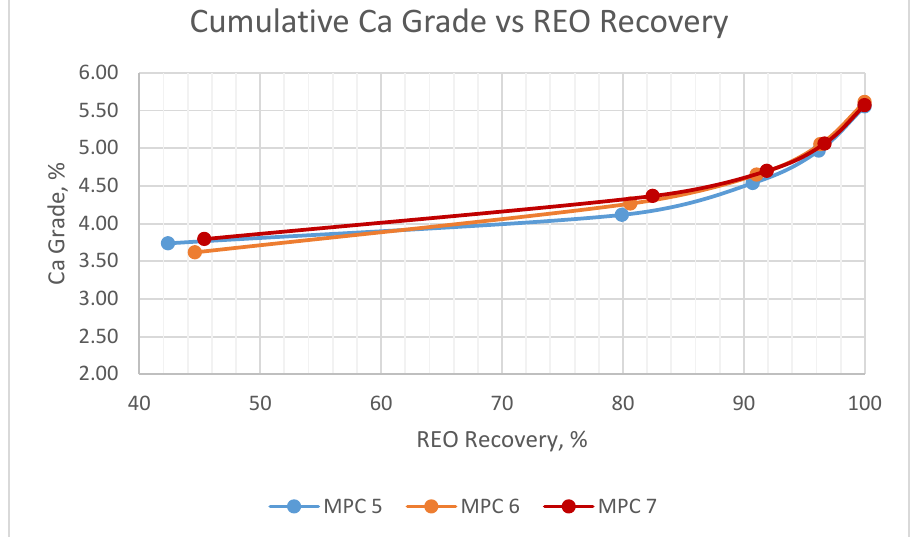
Figure 9. Cumulative gravity concentrate Ca grade vs REO recovery for MPC UF Falcon recovery maximization testing.